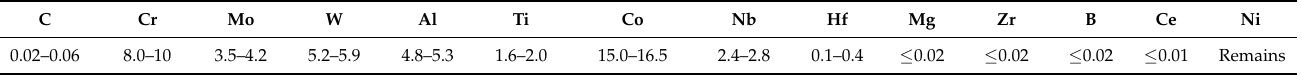
Figure 1. ( a ) Configuration of CT specimens, ( b ) 1.5 s − 1.5 s triangular waveforms, and ( c ) trapezoidal waveforms corresponding to the dwelling time (t Hold ). Table 1. Nominal chemical composition of FGH97 (wt.%) [27].